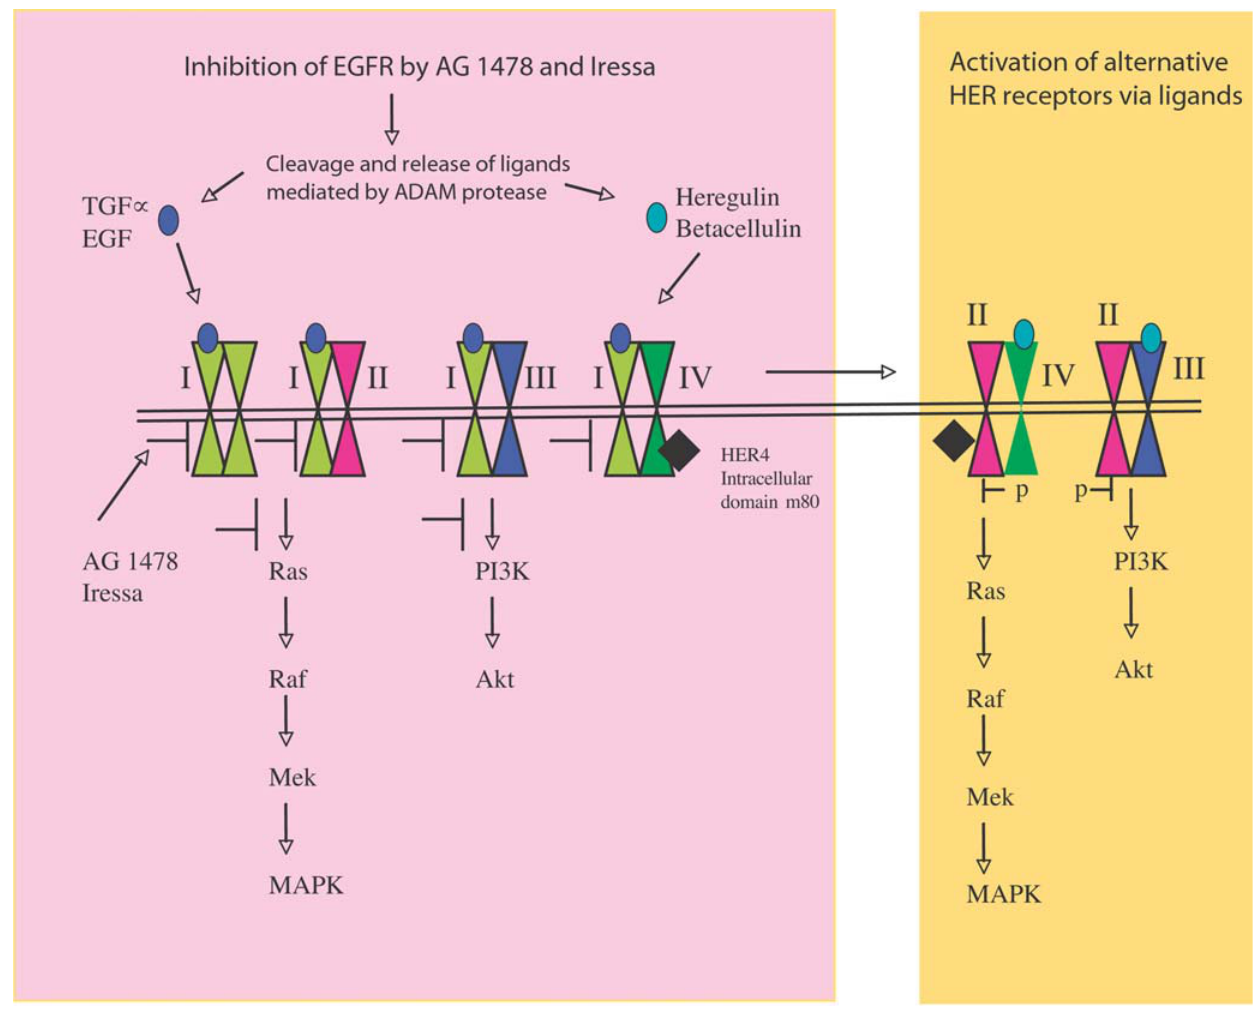
Figure 5. Mechanisms of resistance for tyrosine kinase inhibitors AG 1478 and Iressa. AG 1478 and Iressa treatment induce inactive EGFR homodimers and inactive EGFR/HER2 heterodimers. The treatment also decreases phopho-HER3 levels through inhibition of EGFR/HER3 with a decrease in PKB (Akt) activity. However, the treatment induces the autocrine release of various ligands including heregulin and betacellulin causing activation and cleavage of HER4, which in turn causes dimerization between HER2 and HER4. Following the initial decrease through inhibition of EGFR/HER3, phospho-HER3 as well as phospho-ERK1/2 and phospho-PKB (Ser473) activation augments again within 2 days of treatment due to the release of ligands causing dimerization between HER2/HER3 in addition to